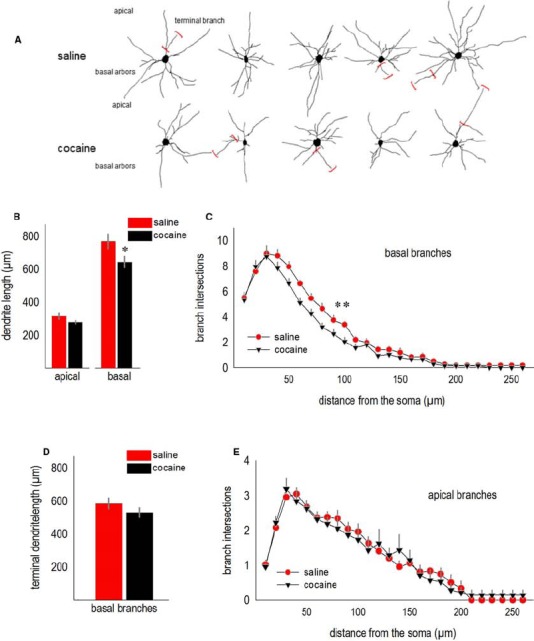
Cocaine exposure during adolescence simplifies oPFC dendrite arbors in adulthood. (A) Representative deep-layer oPFC pyramidal neurons are shown. Terminal branches are indicated by red brackets. (B) Total dendrite length in the apical tree was not significantly affected, but basal lengths were reduced. (C) Simultaneously, dendritic arbors on the basal tree were simplified, as indicated by fewer Sholl intersections 40–100 µm from the soma. (D) The total length of basal terminal branches did not significantly differ between groups, consistent with arbor simplification in relatively close proximity to the soma in (C). (E) Sholl intersections for apical arbors did not differ. Means + SEMs. *p < 0.05 vs. saline, **p < 0.05 for 40–100 µm from the soma.